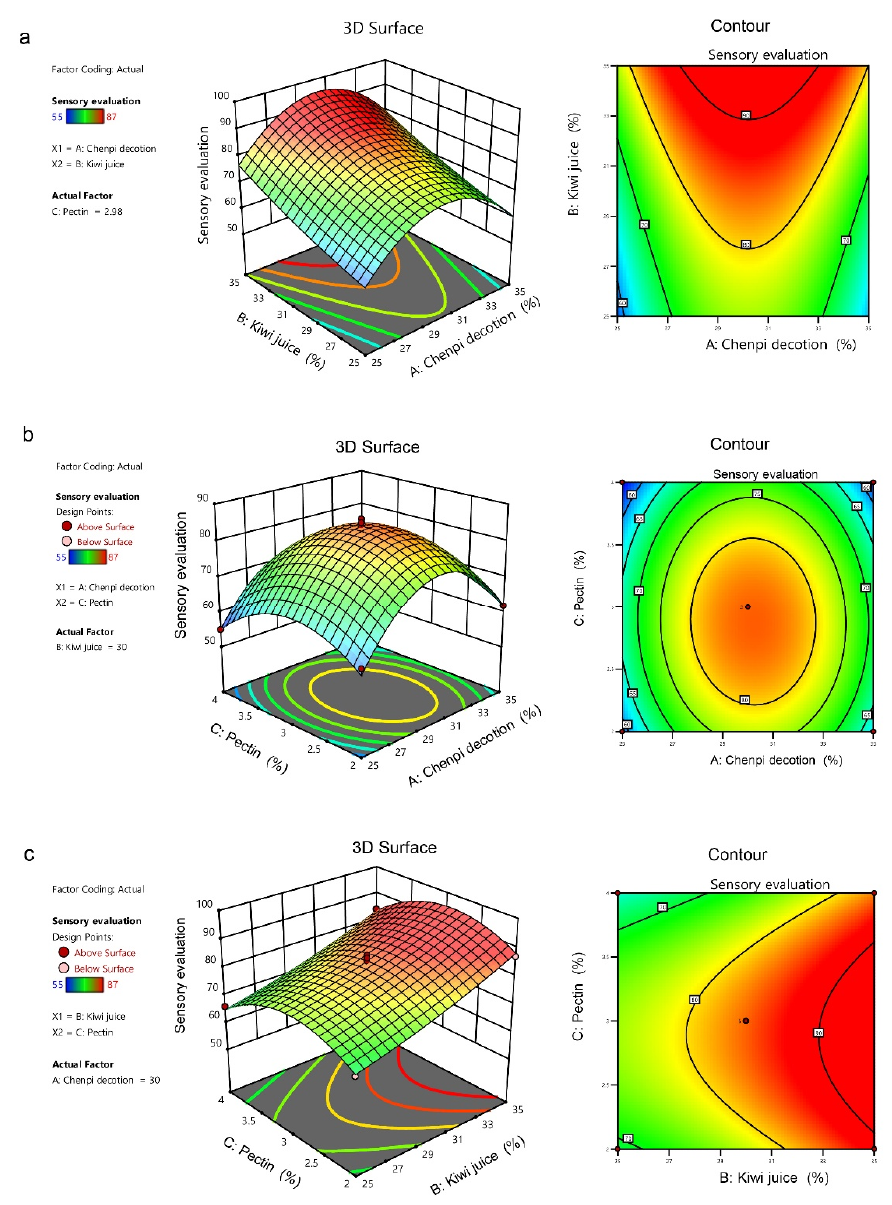
Figure 2. Response 3D surfaces and contours of AB ( a ), AC ( b ), BC ( c ) interaction effects. Table 3. Box–Behnken response surface factors and levels.